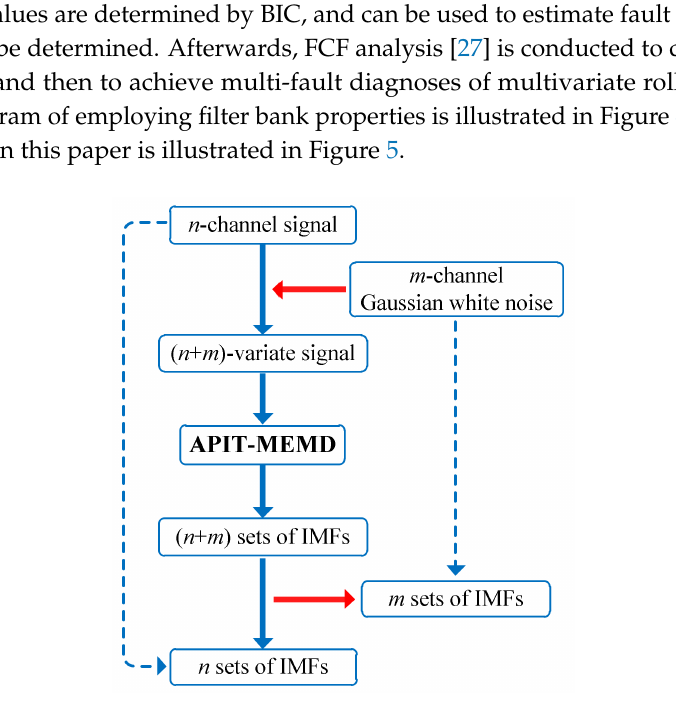
Figure 4. The schematic diagram of employing filter bank